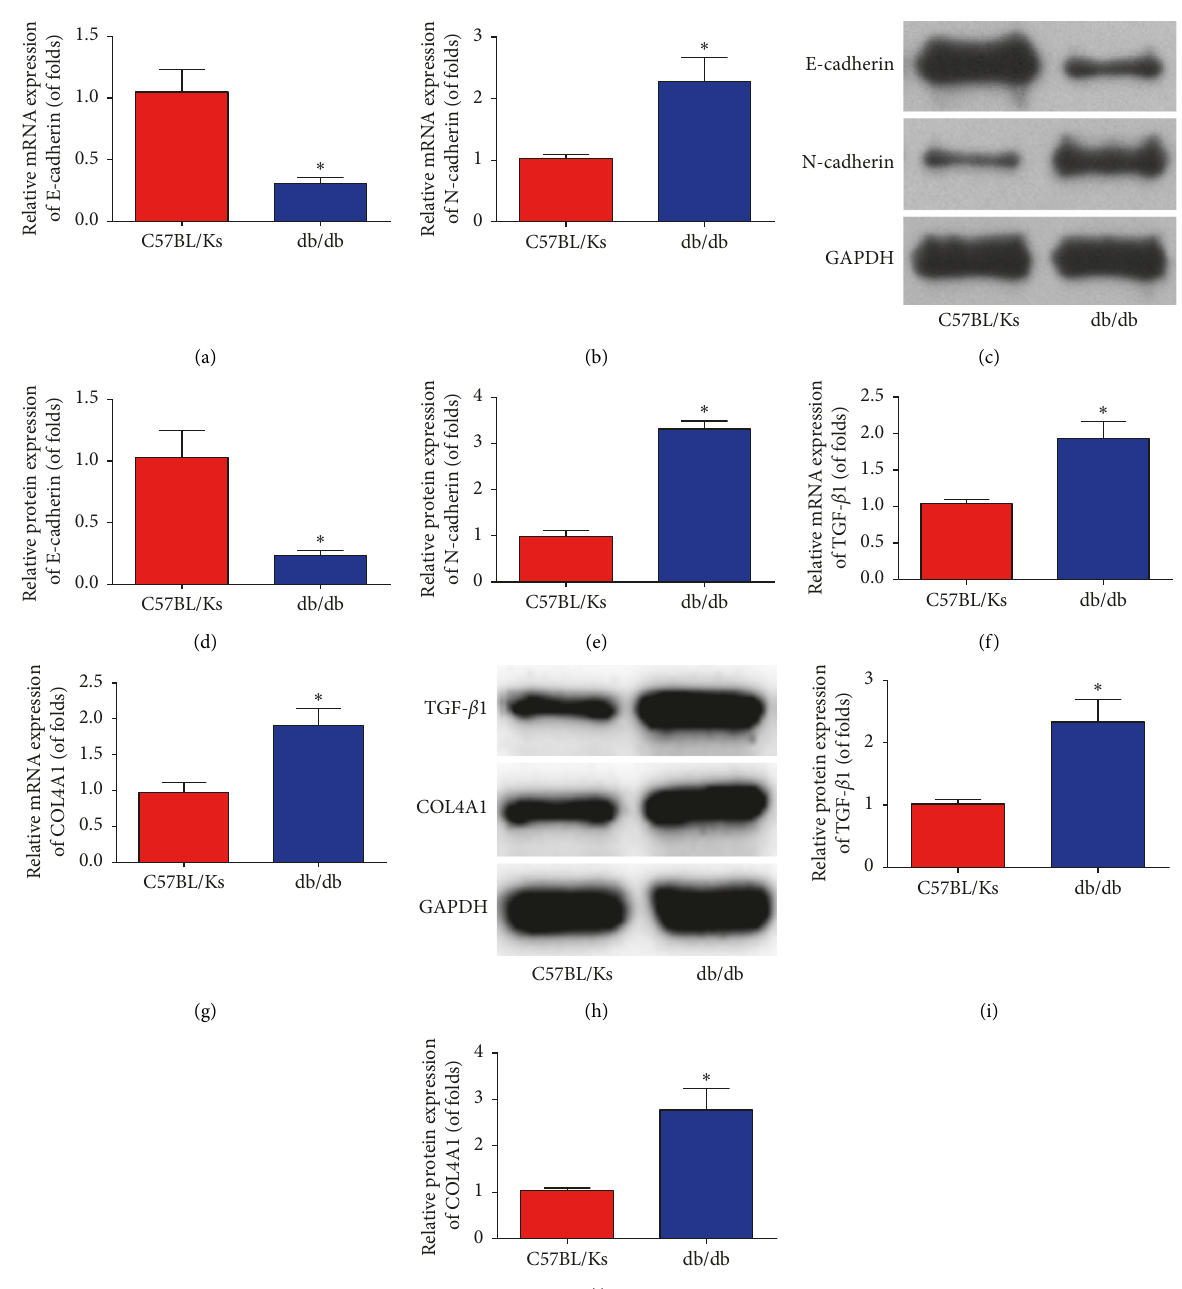
Figure 3: EMT and renal fibrosis was induced in db/db mice. mRNA expression of E-cadherin (a) and N-cadherin (b). The western blot images of E-cadherin and N-cadherin (c). Quantification of the western blot images of E-cadherin and N-cadherin (d and e). mRNA expression of TGF- β 1 (f) and COL4A1 (g). The western blot images of TGF- β 1 and COL4A1 (h). Quantification of the western blot images of TGF- β 1 (i) and COL4A1 (j). n 8 for each group. Data are representative of three experiments. Error bars stand for the mean (cid:31) least triplicate